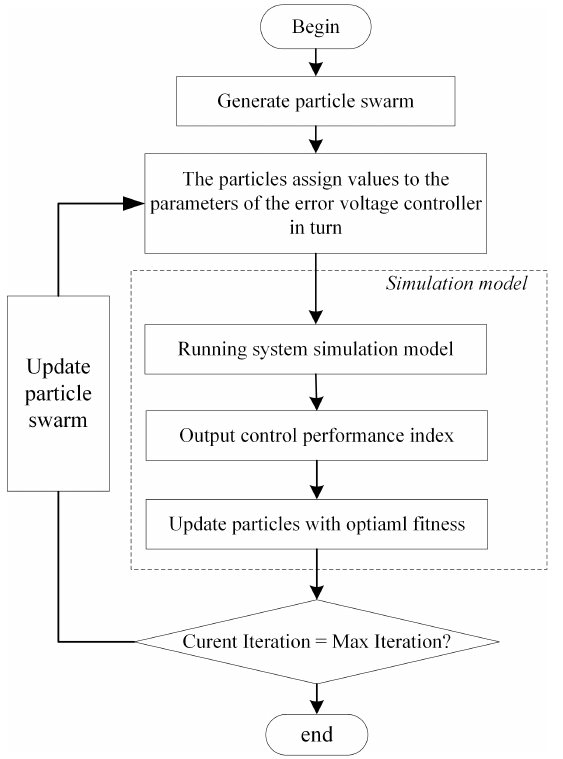
Figure 7. The process of parameter design of error voltage